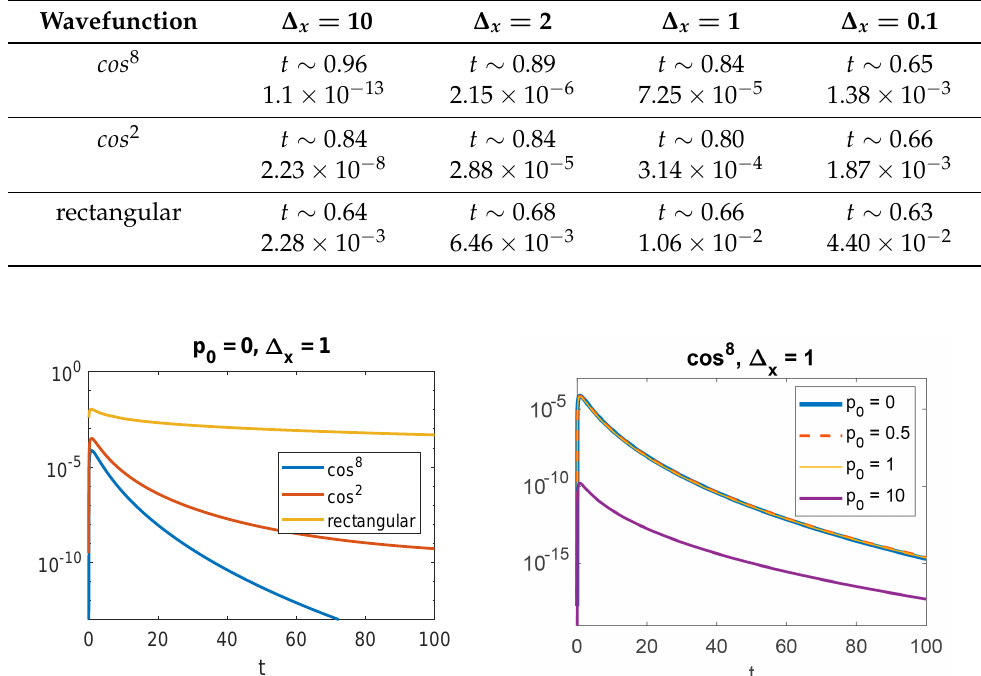
Figure 6. Fraction of the probability density leaking outside the light cone as time evolves. Left panel: Comparison of the three wave different initial compact supports f ( x ) considered in this work, see Equation (19), with p 0 = 0 and ∆ x = 1. Right panel, for the case f ( x ) = cos 8 ( x / ∆ x ) , comparison of different values of the initial momentum p 0 (with ∆ x = 1 in all